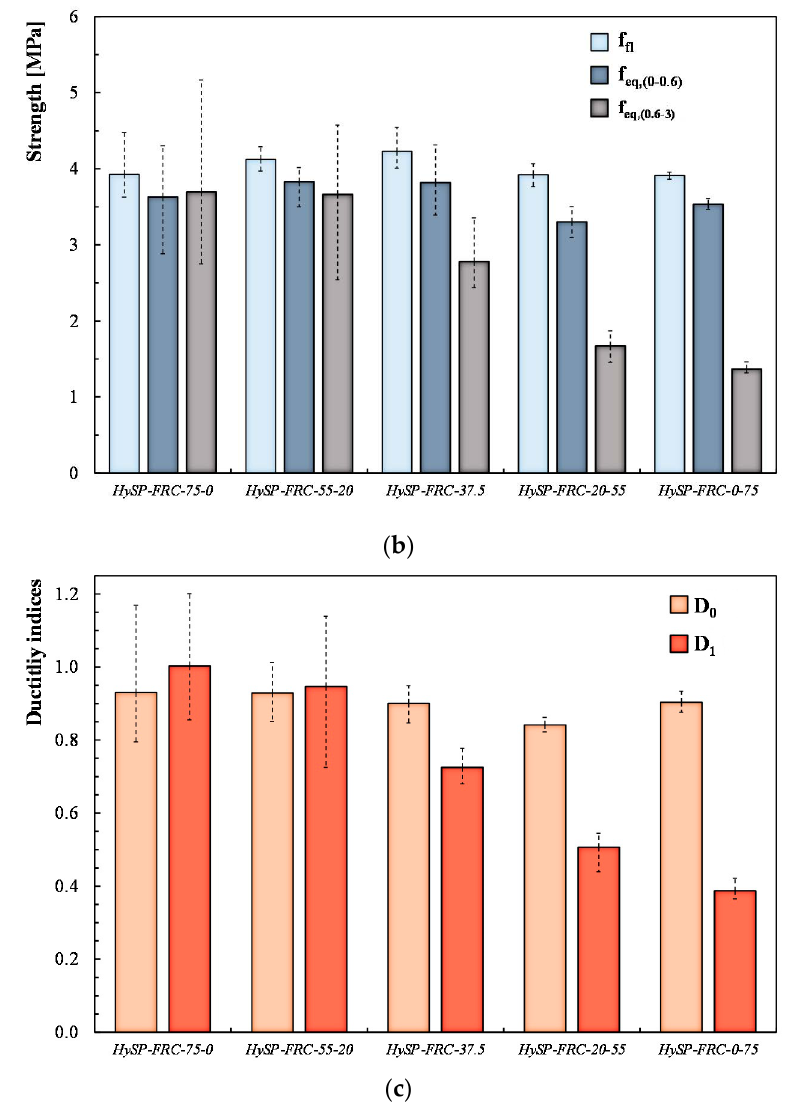
Figure 6. Representative parameters for tested fiber-reinforced concrete (FRC) mixtures: ( a ) work capacity indices, ( b ) first crack and equivalent strengths, ( c ) ductility indices.